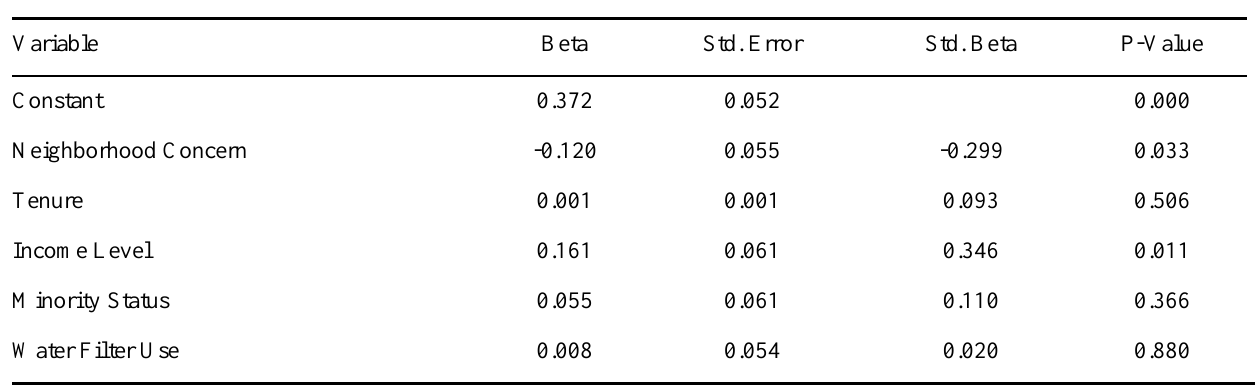
Table 2. Correlates of individual cultural competency